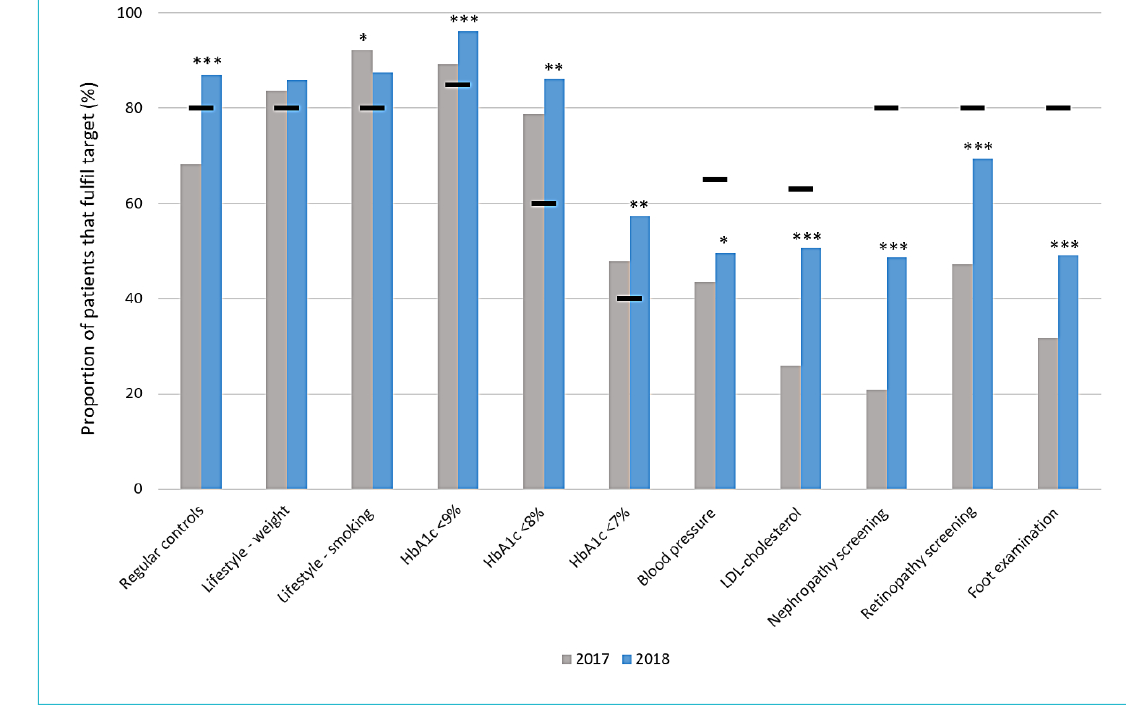
Figure 2: Proportion of patients in pooled analysis whofulfilled the individual diabetes score criteria before and after the criteria for good dis- ease management of diabetes were implemented at the primary care practice. Grey bar: patient data during 2017 (N tot = 727). Blue bar: pa- tient data during 2018 (N tot = 704). Black horizontal lines indicate minimum target value. Regular checks, three or more visits per year; lifestyle – weight, physical activity and weight counselling or body mass index <25 kg/m 2 ; lifestyle – smoking, smoking cessation counselling or non- smoker; glycared haemoglobin (HbA1c) targets, annual average; blood pressure, annual average <140/90 mm Hg; low-density lipoprotein (LDL)-cholesterol, annual average <2.6 mmol/l among patients <75 years of age (N tot 2017 = 440, N tot 2018 = 437); nephropathy screening, as- sessment of serum creatinine and microalbuminuria; eye examination, minimum biannually by ophthalmologist; foot examination, foot pulse and monofilament / vibration sensation assessed. Missing information is treated as failure to reach target throughout the criteria and treatment indicators. Differences in frequencies between 2017 and 2018 assessed by chi-square test * p <0.05; ** p <0.001; *** p